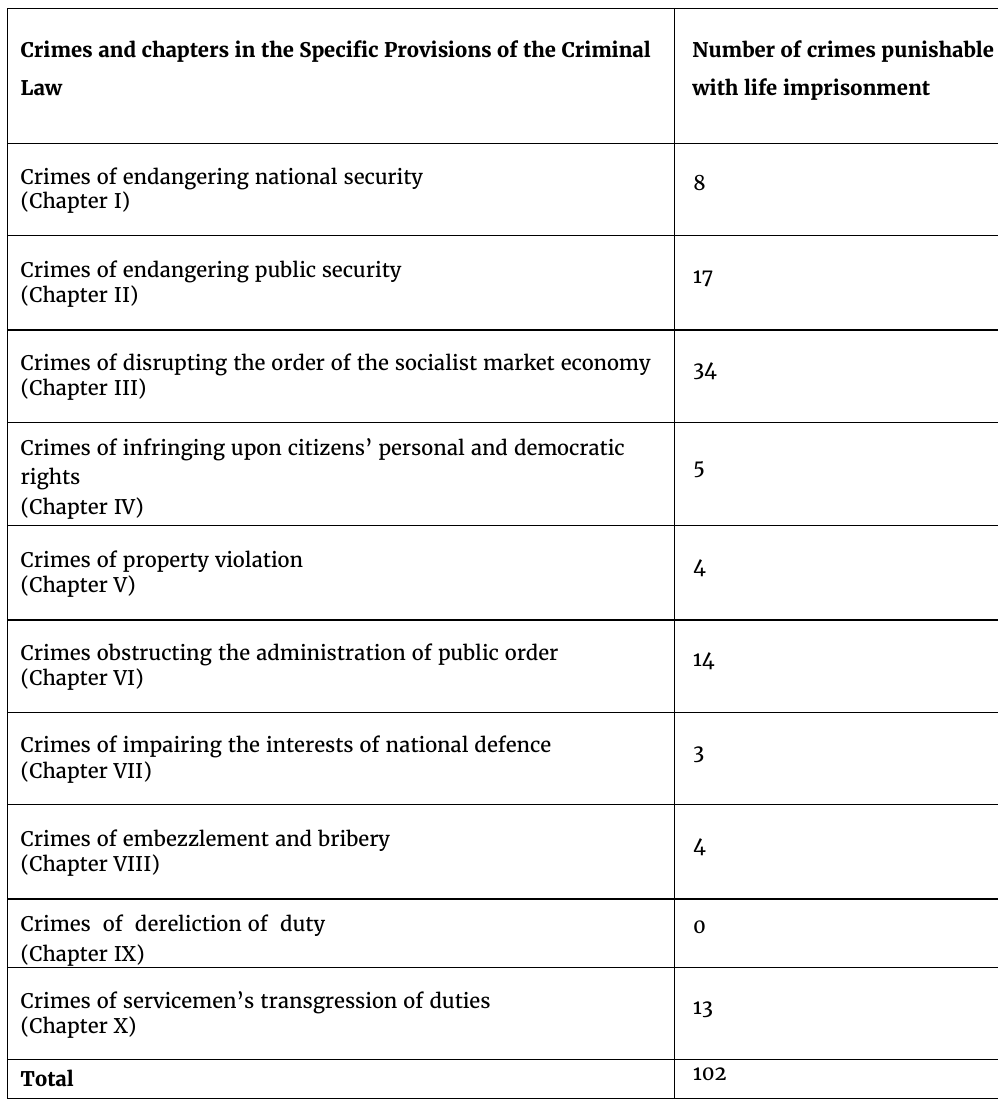
Crimes and chapters in the Specific Provisions of the Criminal